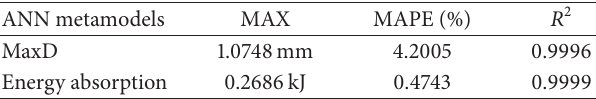
Table 4: Error analysis results of ANN metamodels for MaxD and energy